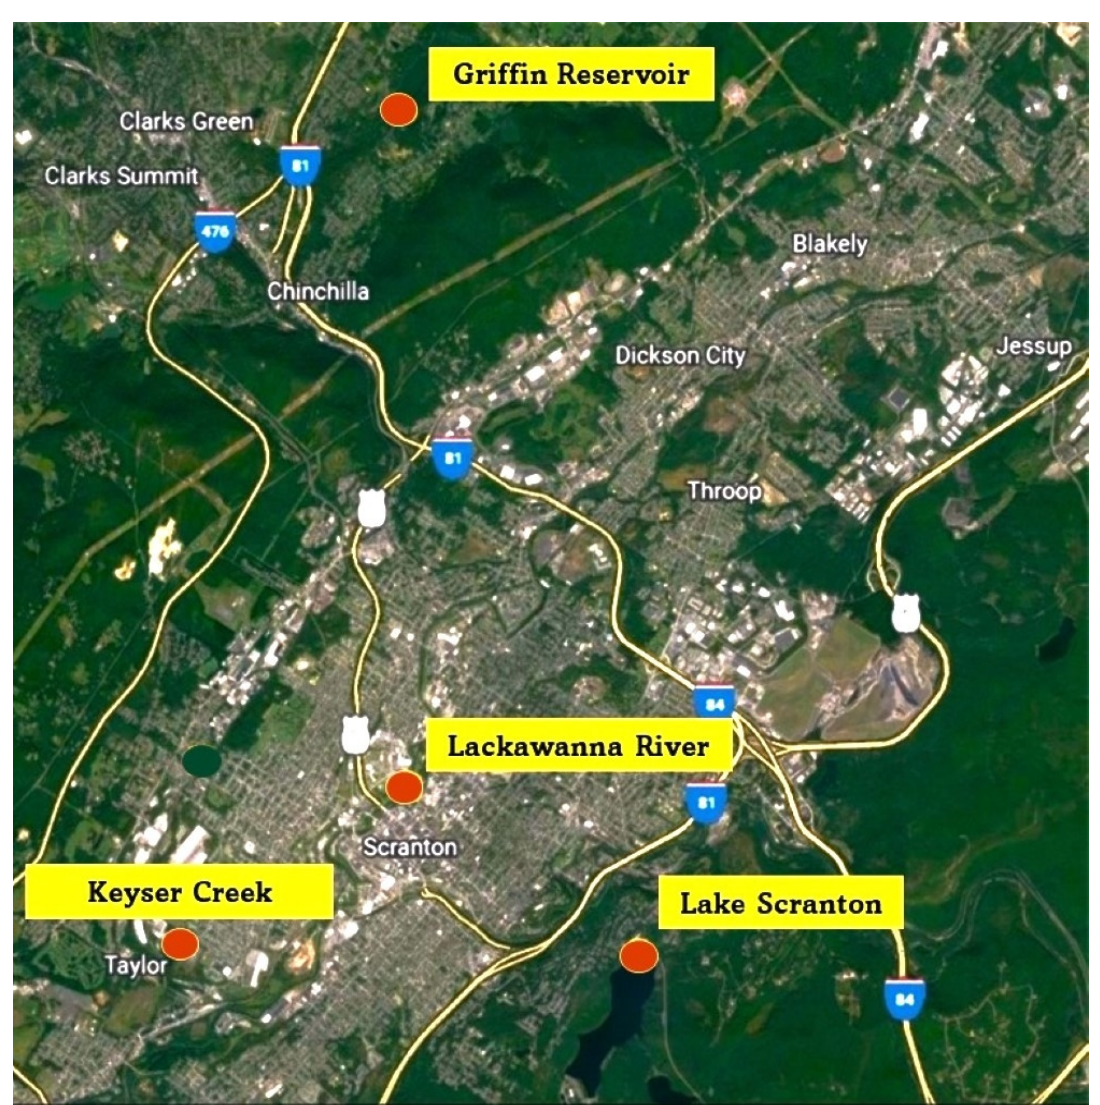
Figure 1. Map showing all water sampling sites as indicated by the red circles.